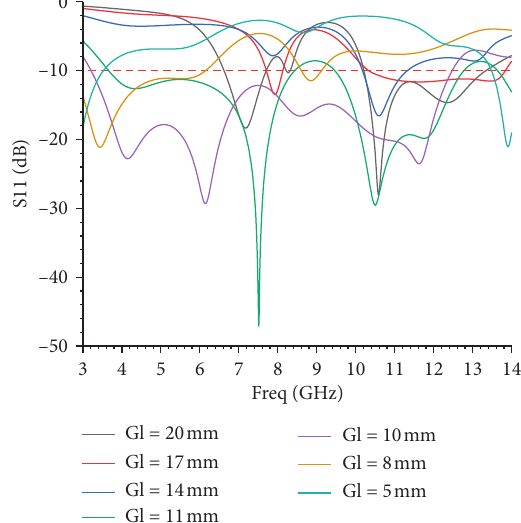
Figure 5: Effect of L g variation on the reflection